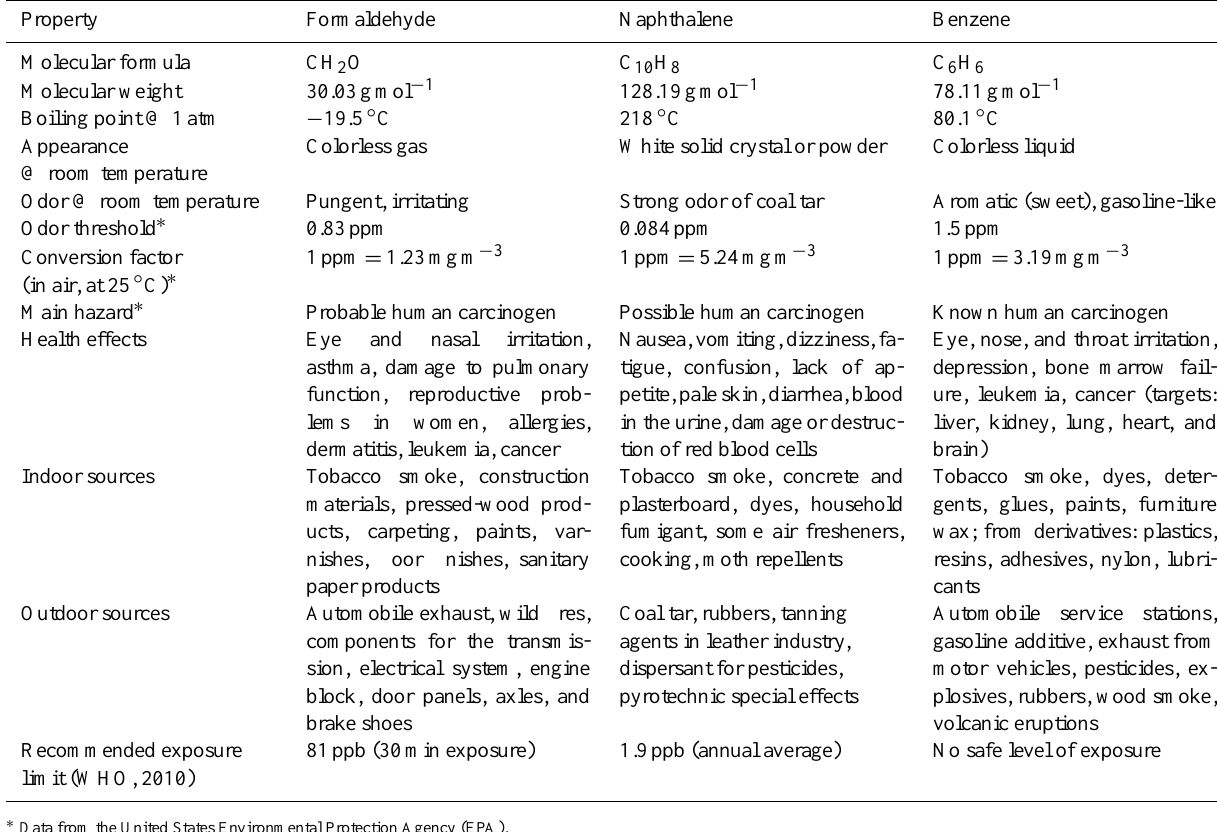
Table 1. Main characteristics of formaldehyde, naphthalene, and benzene.